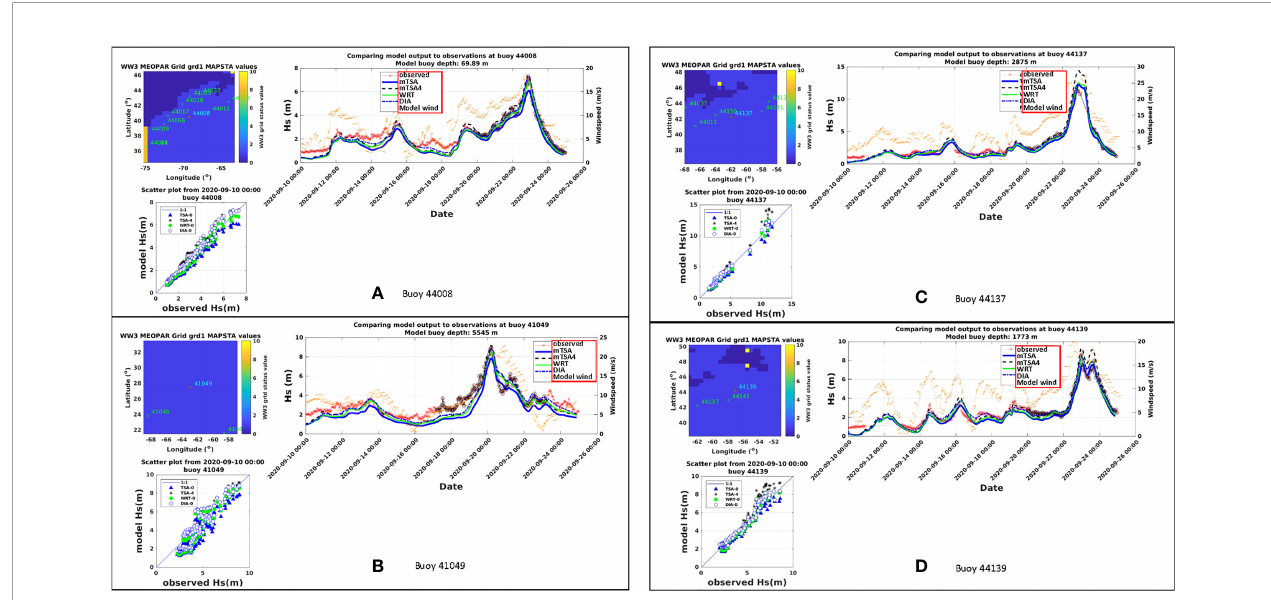
FIGURE 7 | Time series comparisons for signi fi cant wave heights Hs for Hurricane Teddy in 2020; shown for buoys: (A) 41049, (B) 44008, (C) 44137, (D)